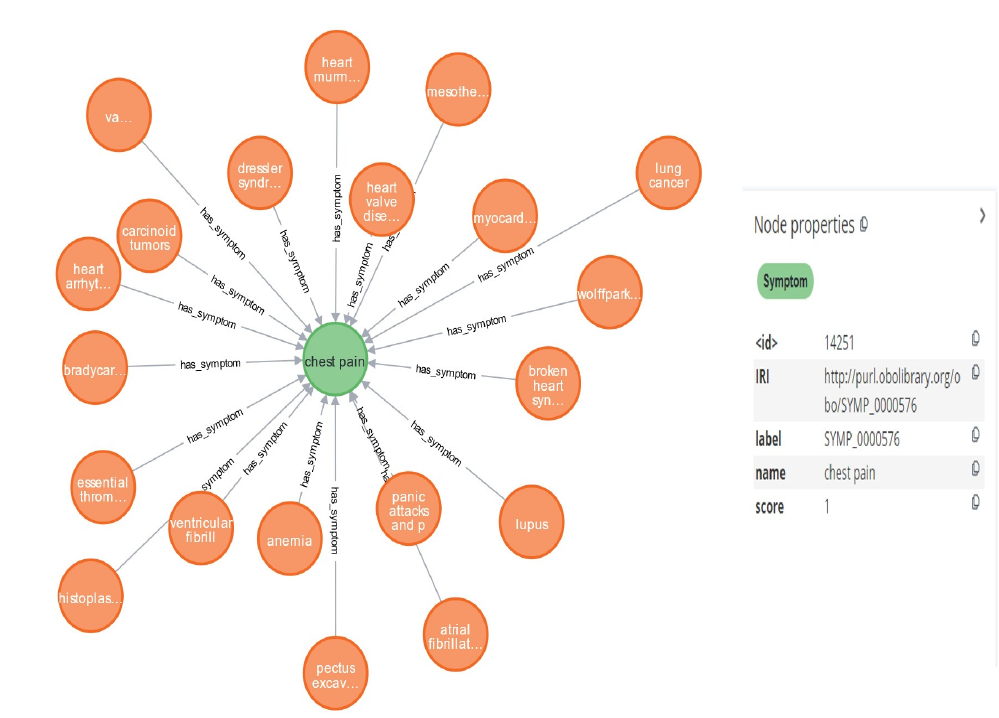
Figure 9. Properties of integrated node ‘chest pain’ as one of the symptoms of ‘lung cancer’ and other